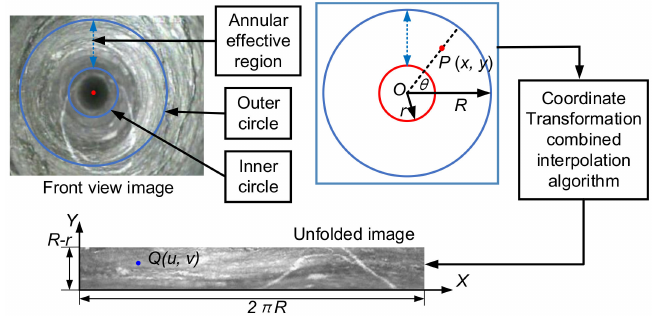
Figure 4. Unwrapping process of front view borehole-wall